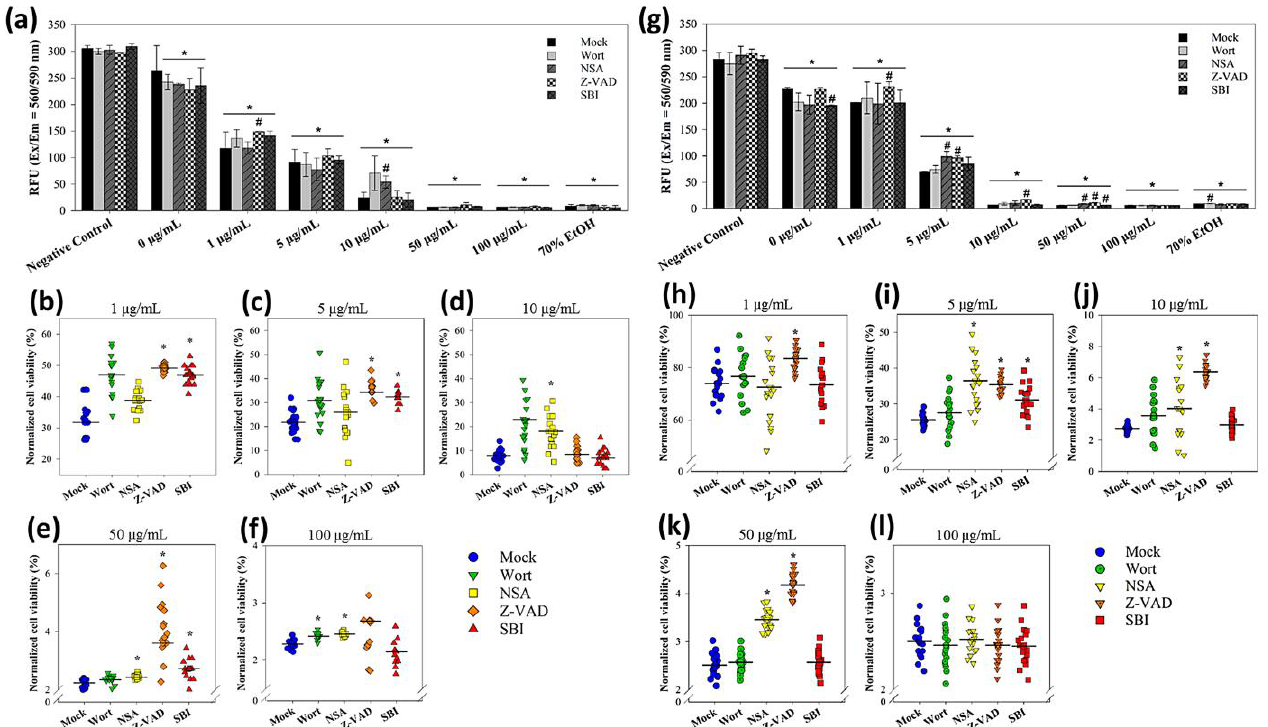
Figure 7. Mechanistic studies of bacterial death due to exposure to 20 or 60 nm CuNPs. ( a ) Viability analysis in the treatments of 20 nm CuNPs with various modulator interventions. Bacteria were treated with PBS (negative controls), 0, 1, 5, 10, 50, 100 μg/mL of 20 nm CuNPs in the absence (mock) or presence of wortmannin (Wort), necrosulfonamide (NSA), Z-VAD-FMK (Z-VAD), and SBI-0206965 (SBI). Cell viabilities were determined by PrestoBlue assay. Relative fluorescence units were acquired at the 590 nm emission from 560 nm excitation. Statistically significance was set at p < 0.05 (* vs. negative control and # vs. mock). ( b – f ) Normalized cell viabilities in the treatments of 20 nm CuNPs corrected for modulators in the negative control. Data are presented as mean ± SD from eighteen independent experiments performed in triplicate for each treatment. Differences from the mock were considered significant at p < 0.05 (*) using one-way ANOVA. ( g – l ) For comparison, the same viability analysis and normalized cell viability analysis were conducted in the treatments of 60 nm CuNPs with various modulator interventions. Data in ( h – l ) are presented as mean ± SD from nineteen independent experiments performed in triplicate for each treatment group.